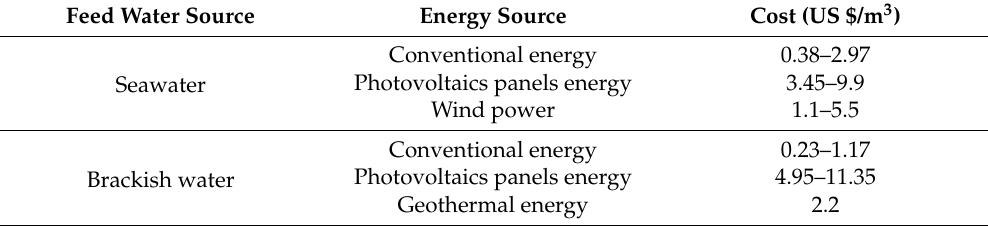
Table 2. Cost of desalination water produced per feed water and energy sources, adapted from